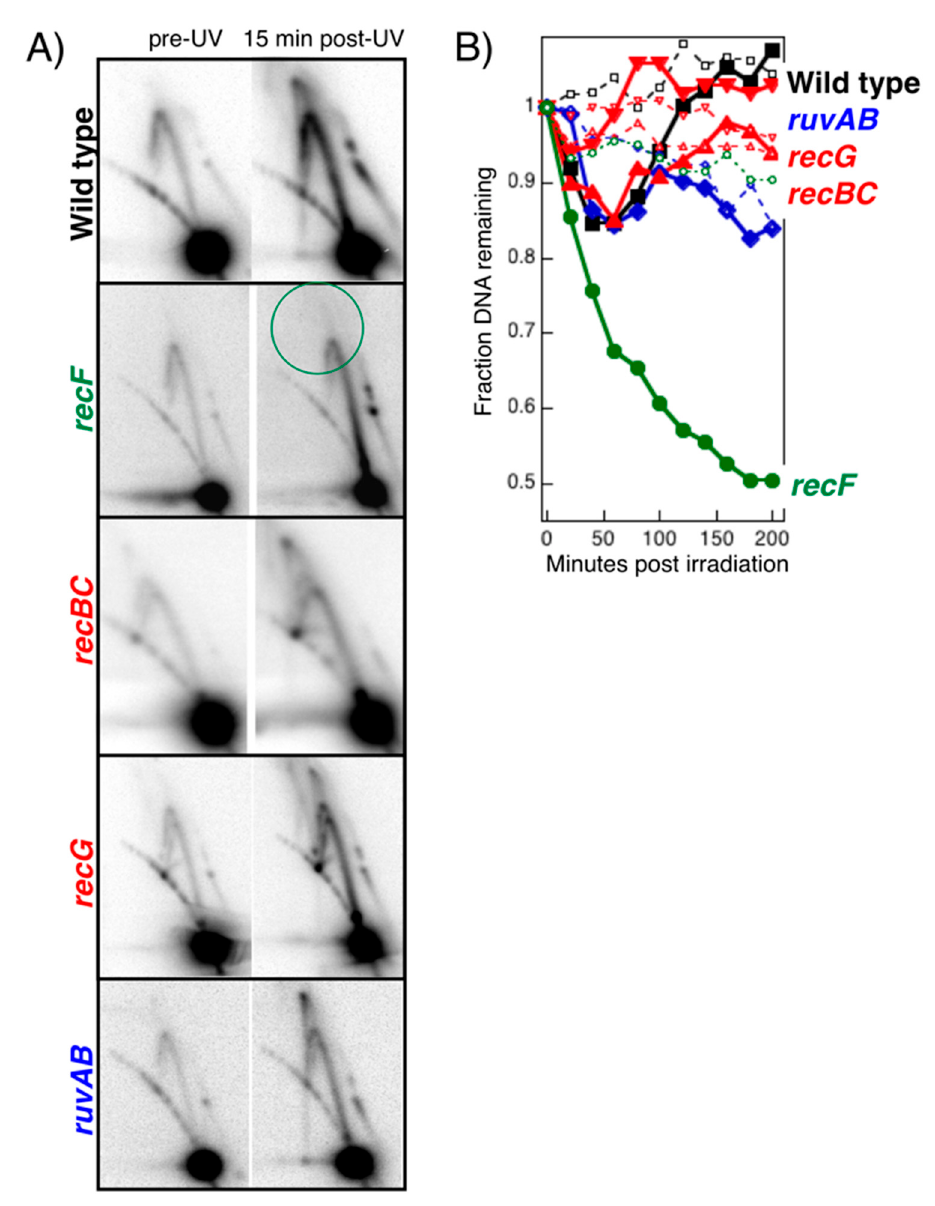
Figure 12. Processing of disrupted replication forks is specific to the RecF pathway. ( A ) The absence of processing intermediates seen at disrupted replication fork is specific to recF mutants. DNA from cells containing the plasmid pBR322 were purified, digested with Pvu II, and analyzed by 2D agarose gels immediately before and 15 min after UV irradiation with 50 J/m 2 . Cone region intermediates resembling those in wild-type cells appear in recBC , recG , and ruvAB mutants, but are missing in recF mutants. ( B ) The inability to protect the nascent DNA from degradation is specific to the RecF pathway. A 10 s pulse of [ 3 H]thymidine is added to [ 14 C]thymine-prelabeled cells immediately before the cells are filtered and irradiated with 25 J/m 2 in nonradioactive medium. The loss (or deg- radation) of 14 C genomic DNA (open symbols) can be compared with the loss of the 3H DNA syn- thesized at the growing fork just before irradiation (filled symbols). Squares, wild type; circles, recF ; diamonds, recBC ; triangles, recG ; inverted triangles, ruvAB . Data adapted from [53,80,91].